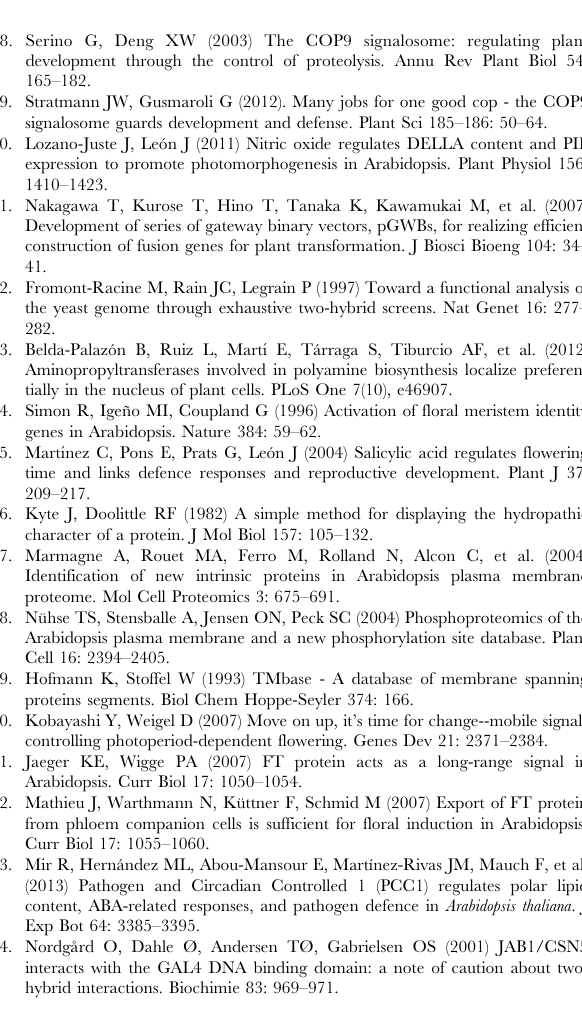
Figure S1 Co-localization of GFP-PCC1 with stained membranes. Membranes were stained with fluorescent lipid stain FM64 in Nicotiana benthamiana leaves transformed with 35S::GFP-PCC1 and 35S::GFP- D 177-PCC1 constructs expressing the full and truncated versions of tagged PCC1 proteins. Overlays of green and red fluorescence due to GFP and FM64 are shown in the right panels and yellow appeared only when co-localization occurred. Figure S2 PCC1-GFP is localized only in the plasma membrane in plasmolysed cells of transformed Nicoti- ana leaves. Nicotina benthamiana leaves transiently transformed with 35S::PCC1-GFP construct were either infiltrated with water (control) or with 0.5 M sorbitol (plasmolysed) and 6 h after infiltration fluorescence was observed under confocal microscopy. Cell contour is marked with red dashed lines. Figure S3 PCC1 is not localized in plastids. Green fluorescence due to GFP and red fluorescence due to FM64 in membranes and to chlorophyll in plastids (pointed by arrows) are shown together with the corresponding bright field photopgraphs.